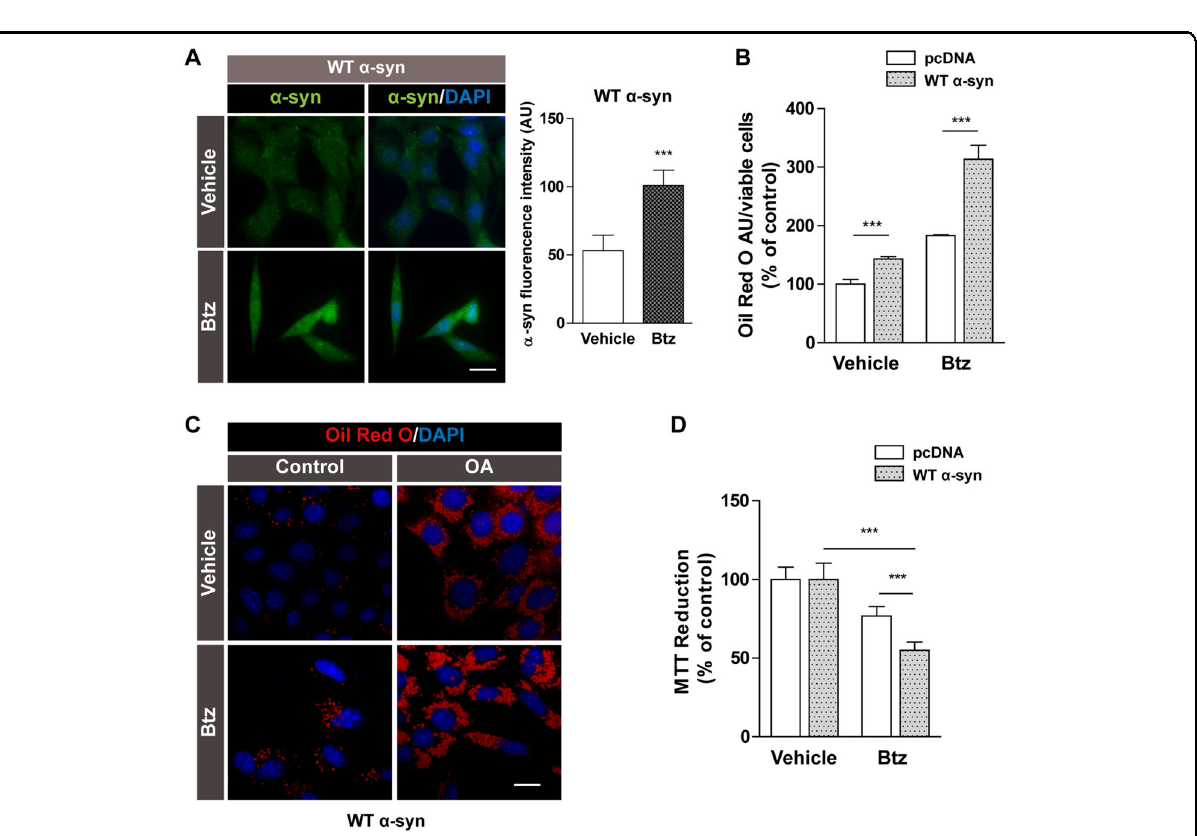
Fig. 6 Btz treatment rendered neurons more vulnerable to α -syn expression. A Immunocytochemistry studies show the increased expression levels of α -syn under proteasome blockage by Btz in WT α -syn cells. DAPI was used as nuclear marker. B , C The effect of Btz treatment on neutral lipid accumulation was assessed by spectrophotometric measurement of Oil Red O in pcDNA and WT α -syn cells and microscopic visualization of Oil Red O staining under OA exposure of cells overexpressing α -syn. DAPI was used as nuclear marker. D Neuronal fate changes induced by Btz treatment were determined by the MTT reduction assay. A – D Scale bars 20 µm. All experiments were repeated three times. Bars represent means ± standard deviation (SD, n = 3). *** p < 0.001 vs.